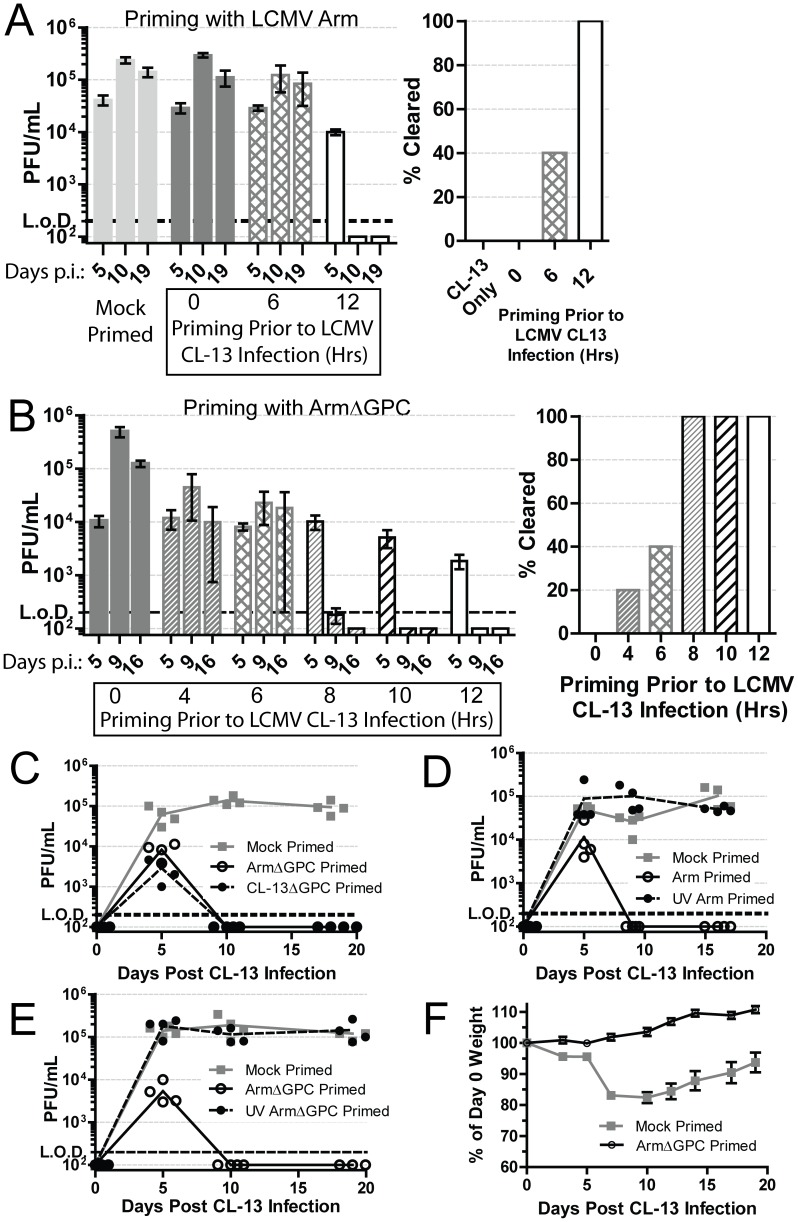
Priming an LCMV infection leads to early clearance.A) Mice (n = 5/group) were either mock (PBS) or Arm (2×106 ffu, i.v.) primed 6 or 12 hours prior to, or concurrently, with Cl13 (2×106 ffu, i.v.) infection. At 5, 10 and 19 days post-infection serum virus titers were determined by plaque assay on Vero cells. The right panel shows mice (%) that had cleared viremia (<200 pfu/ml in serum) by day 19 post-infection Data are representative of three independent experiments. B) Same as A except mice were primed with ArmΔGPC at the indicated intervals. Data are representative of two independent experiments. C) Mice (n = 4/group) were mock (PBS) or ArmΔGPC (2×106 ffu, i.v.) or Cl13ΔGPC (2×106 ffu, i.v.) primed 12 hours prior to Cl13 infection ((2×106 ffu, i.v.) and virus titers in serum determined as in (A) at the indicated times. D+E) Mice (n = 4/group) were mock primed or primed with UV-irradiated or non-irradiated Arm (D) or ArmΔGPC (E). Serum virus titers were determined as in (A) at the indicated time points. F) Mice (n = 19 mice/group) were either mock (PBS) or ArmΔGPC (2×106 ffu/ml) primed 12 hours before infection with Cl13 (1×105 ffu/ml, i.v.) and weighed at the indicated times. Data in C–E are representative of two independent experiments.